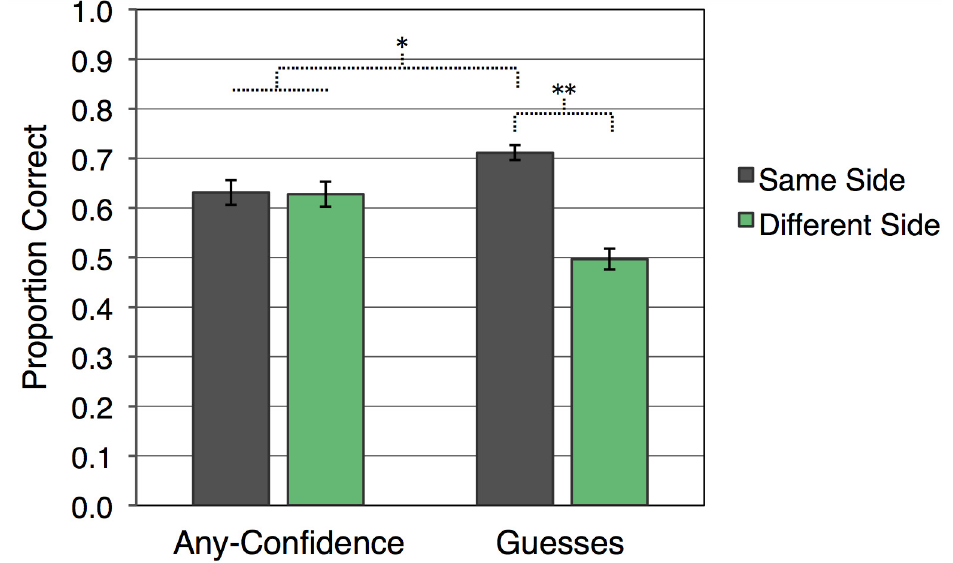
Figure 1. Mean recognition accuracy for each condition (error bars indicate SEM ; ** p < 0.001; * p <